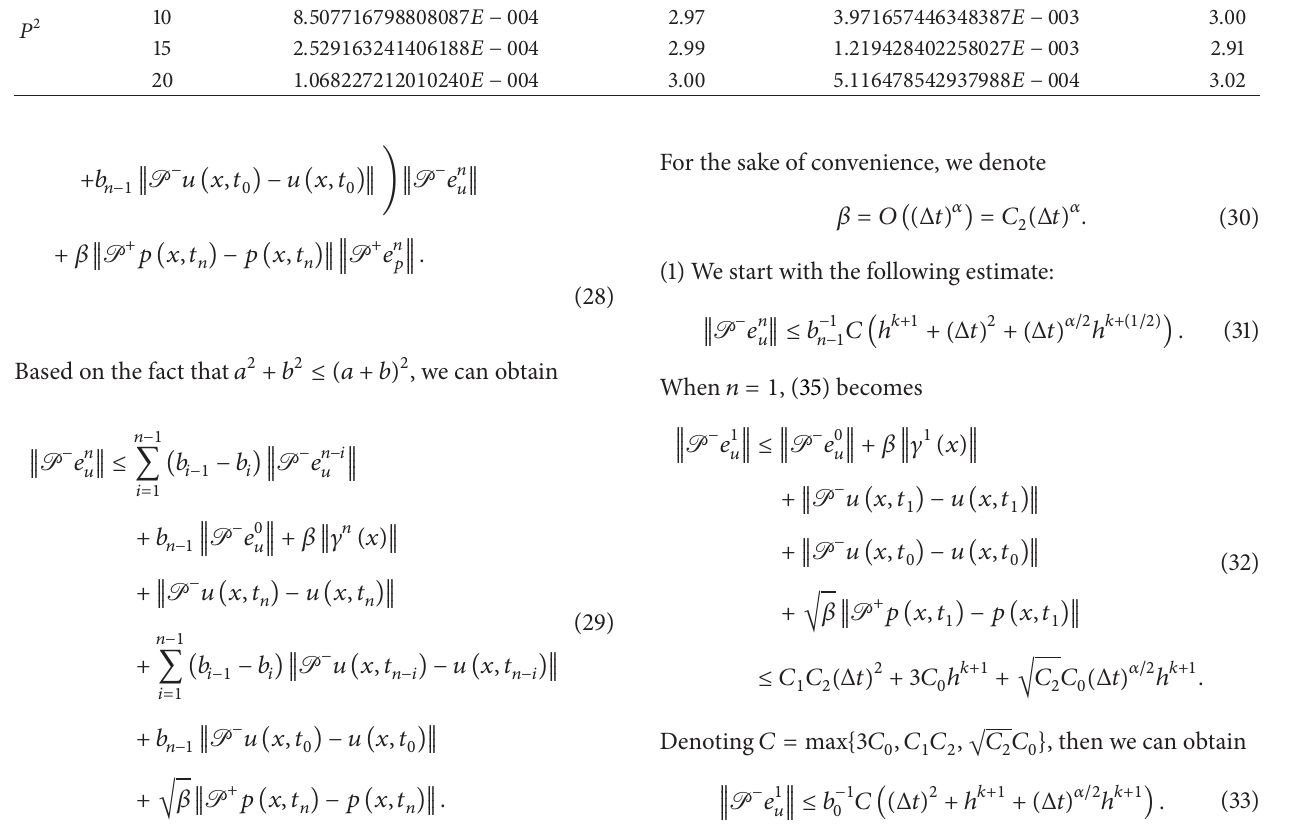
6.740140755904378𝐸 − 002 — 0.250047569176264 —